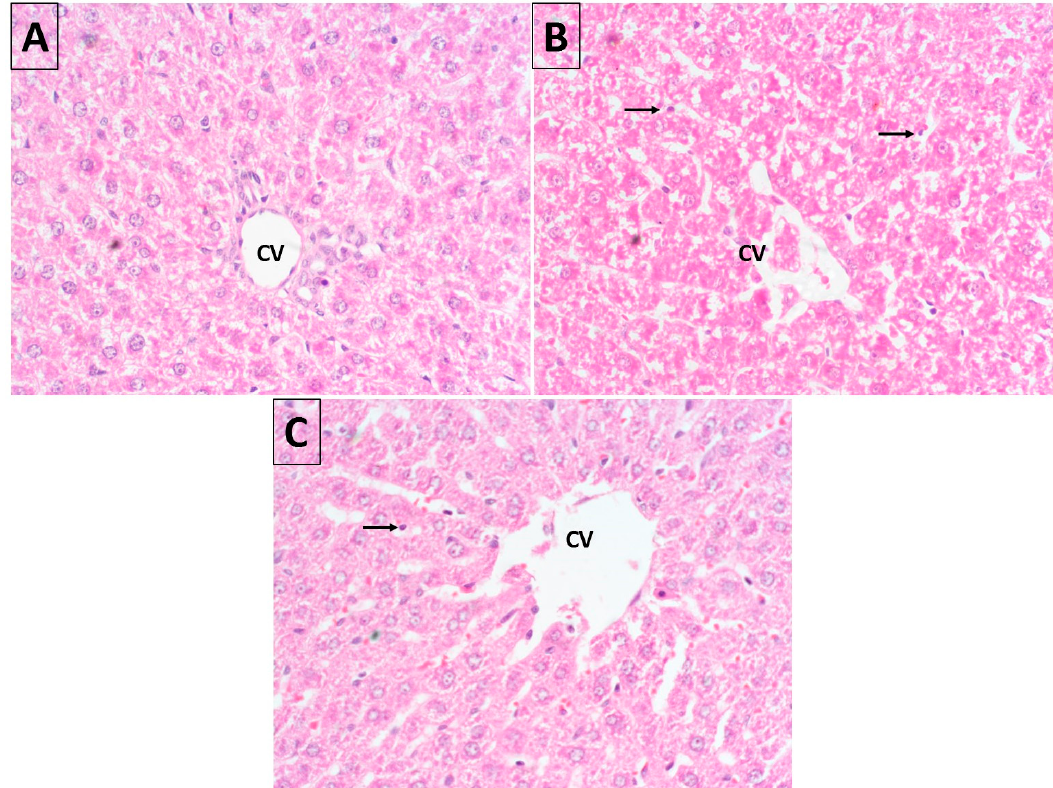
Figure 8. Morphological changes were observed by H&E staining induced by Cyp. Normal cell morphology and central hepatic vein were detected in the control group ( A ), while treatment with Cyp shows accumulation of inflammatory cells in the portal triads which had pyknotic nuclei ( B ). However, the co-treatment of Cur-NLC shows the reversal of histopathological changes with partial cell damage at a 5 mg Cur-NLC dose ( C ). (Data from 1 mg and 2.5 mg not shown.) Magnification, 40×.